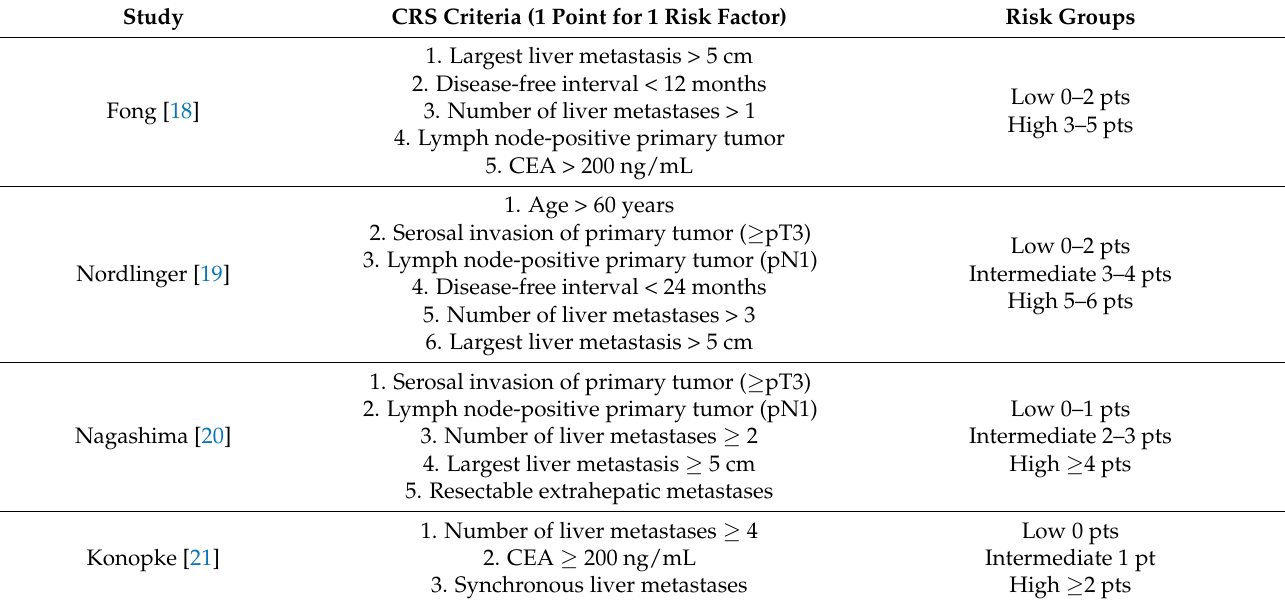
Table 1. Clinical risk